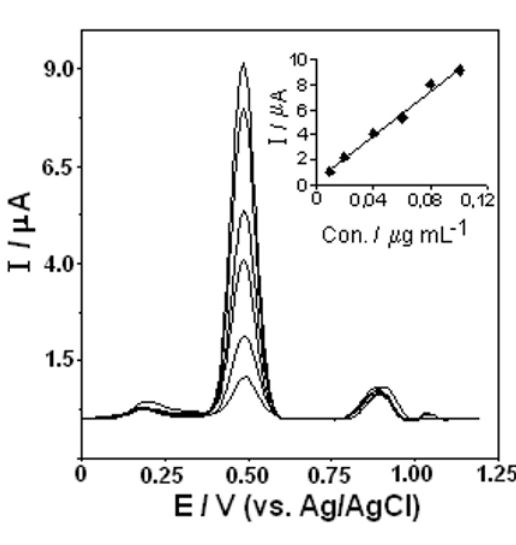
Figure 4. SW stripping voltammograms in BR buffer, pH 4.0 containing different concentrations of rutin (from inner to outer: 0.01, 0.02, 0.04, 0.06, 0.08 and 0.1 μg mL -1 ). Inset depicts a corresponding calibration plot for the quantitation of rutin. Pre-concentration period, 60 s at a fixed potential of 0.2 V; SW parameters: frequency, 125 Hz; scan increment, 8 mV; pulse amplitude, 40